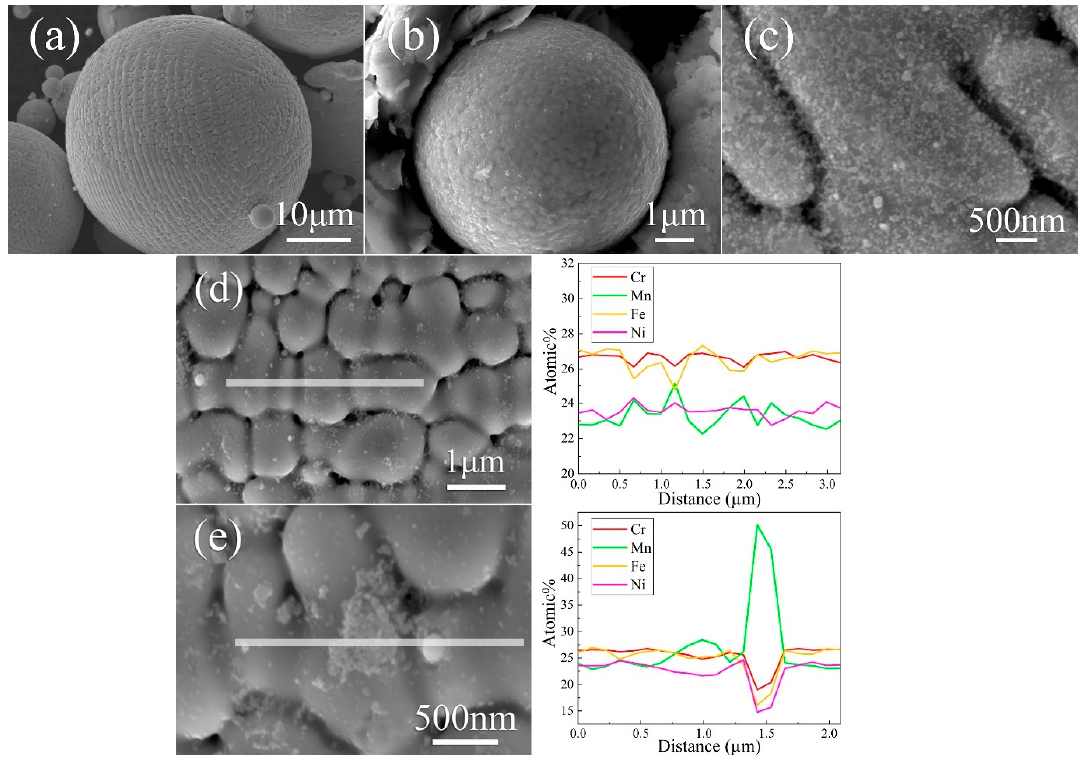
Figure 1. Surface morphology and EDS line scan on the surface of CrFeNiMn powder. The SE micrographs of ( a ) large particle; ( b ) small particle; ( c ) debris on a random powder surface. The EDS line scan ( d ) across cell structures and ( e ) across one nano-inclusion and -debris.